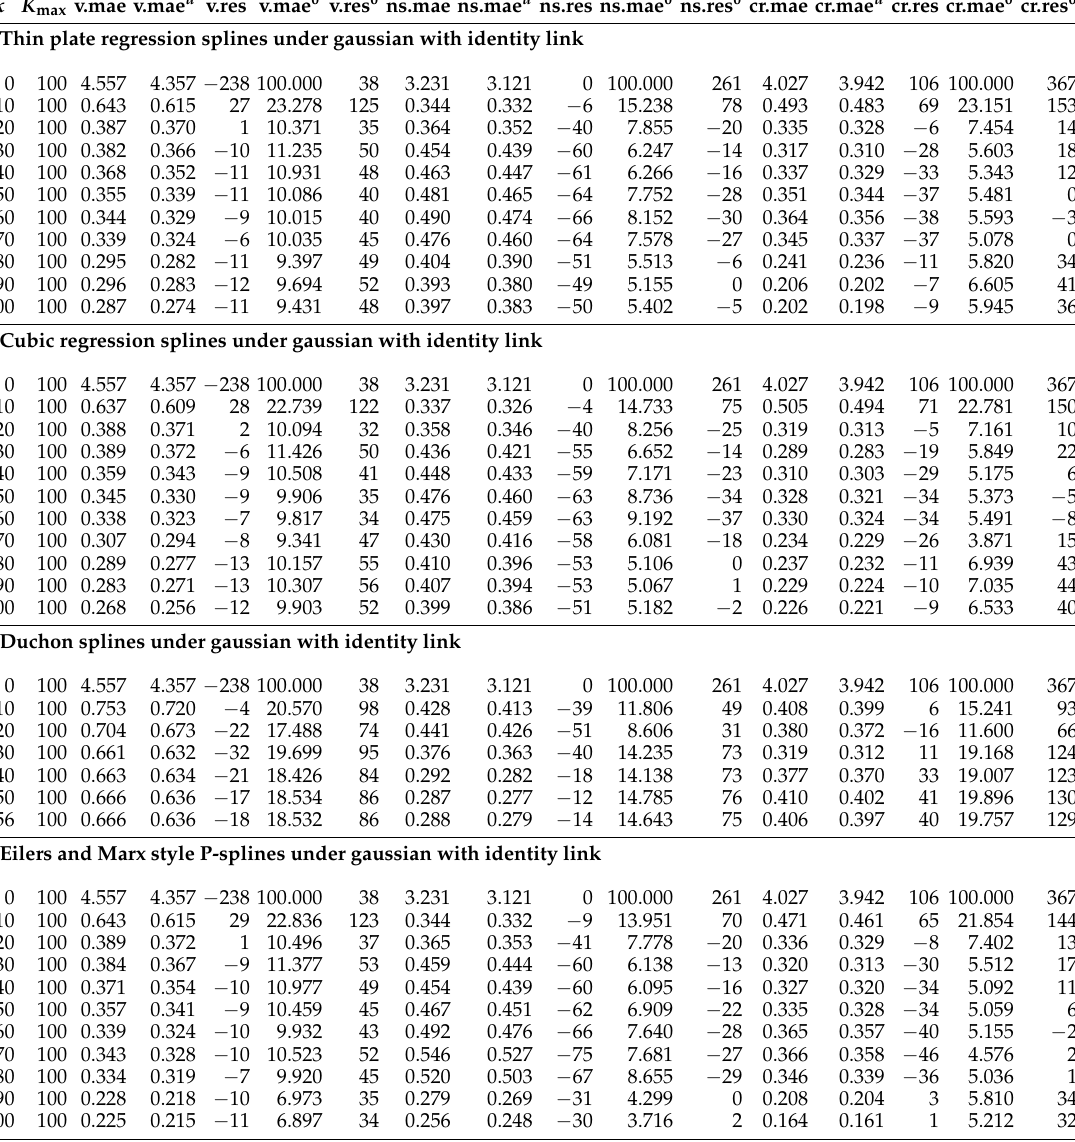
Table A17. Out-of-sample validation figures of selected GAMs of BEL with varying spline function type and fixed spline function number of 5 per dimension under 100–443 after each tenth and the finally selected smooth